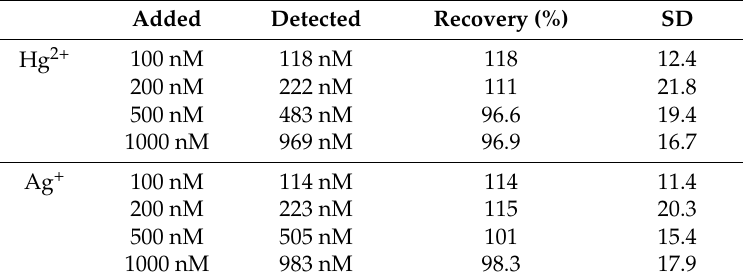
Table 5. Detection of Hg 2+ and Ag + in actual samples.